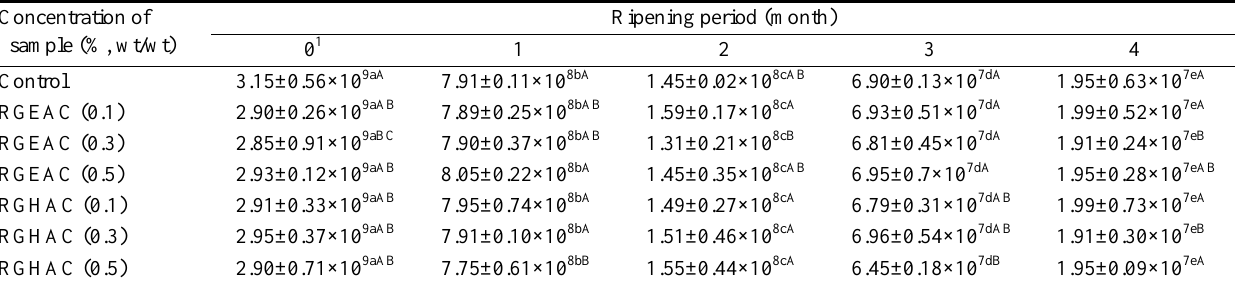
Ripening period